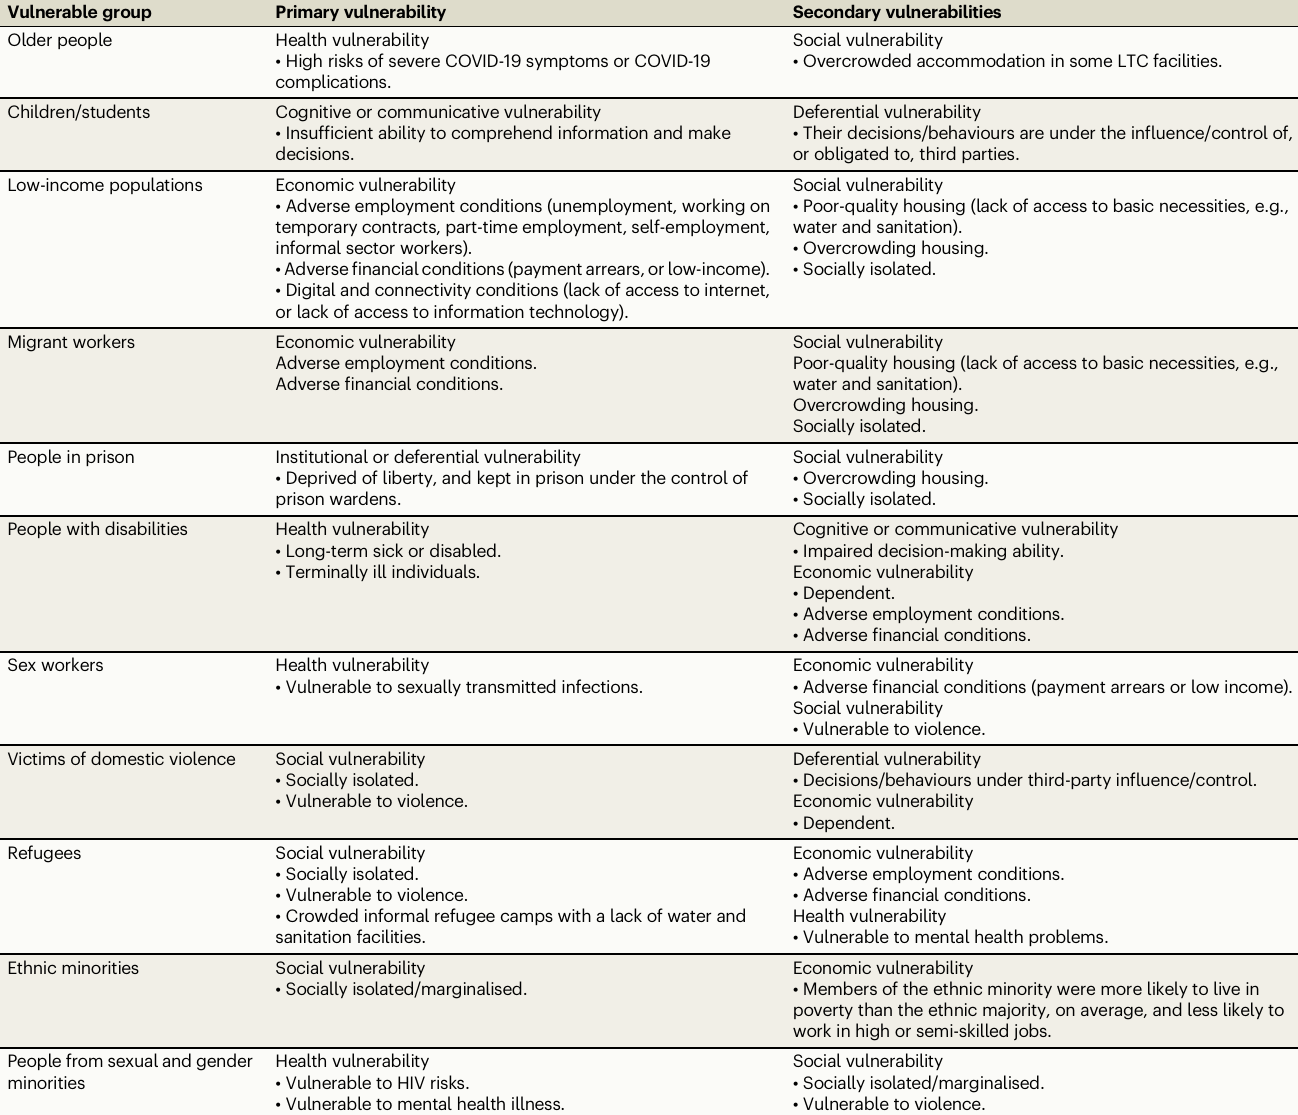
Table 2 | Different vulnerable groups and their vulnerabilities, as discussed in the literature Vulnerable group Primary vulnerability Older people